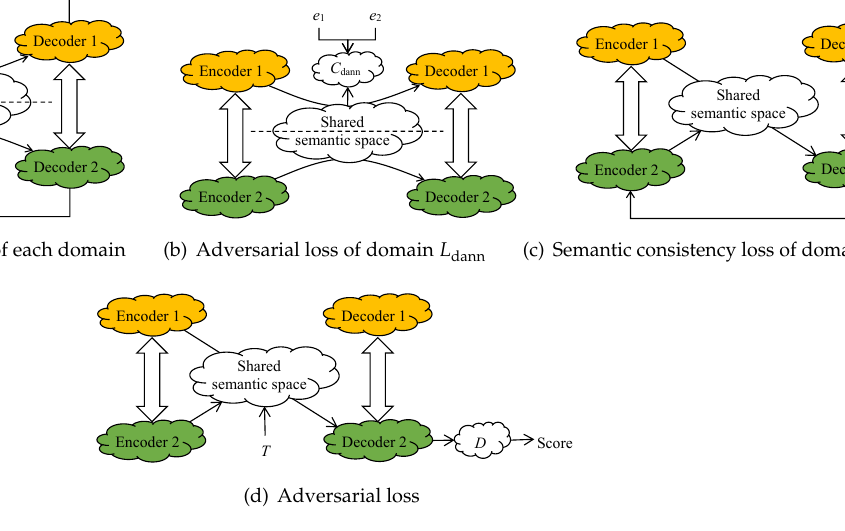
Figure 5. The framework of XGAN. Generally speaking, it is composed of two encoders and two decoders. As for the loss function, L dann assures the quality of the encoding, and L sem preserves the semantics after domain transfer. Specifically, in ( a ), each domain in XGAN has their own encoder-and- decoder. In ( b ), the domain adversarial loss is used to moderate the differences in semantic features between two domains. In ( c ), the semantic consistency loss is used to ensure that the semantic features generated have the same meanings in different domains. ( d ) Is the whole architecture of